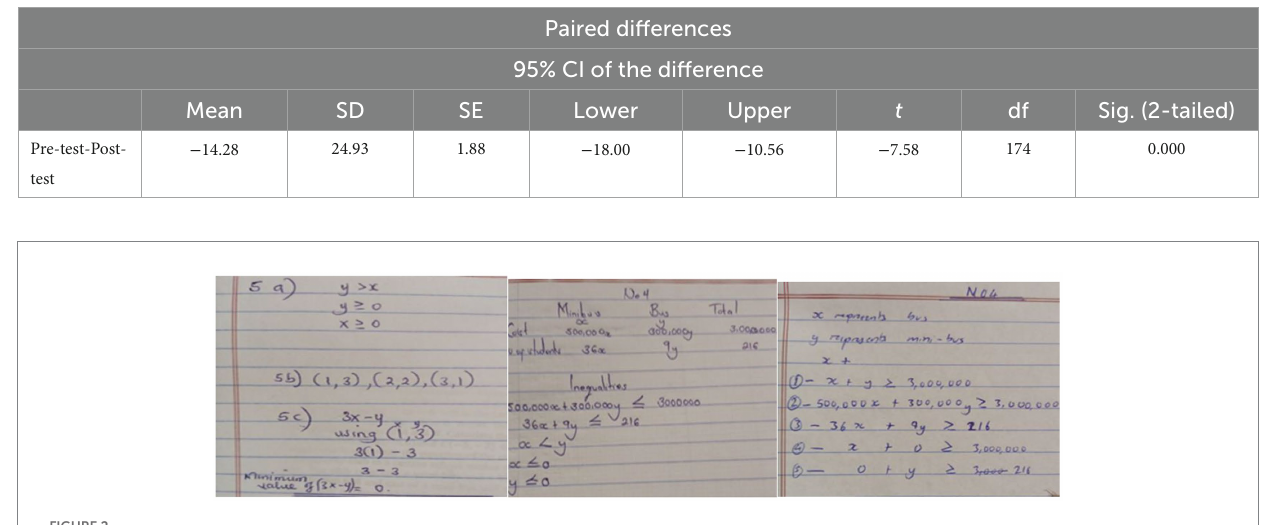
FIGURE 2 Showing students’ Vignettes in terms of misconceptions in solving LP